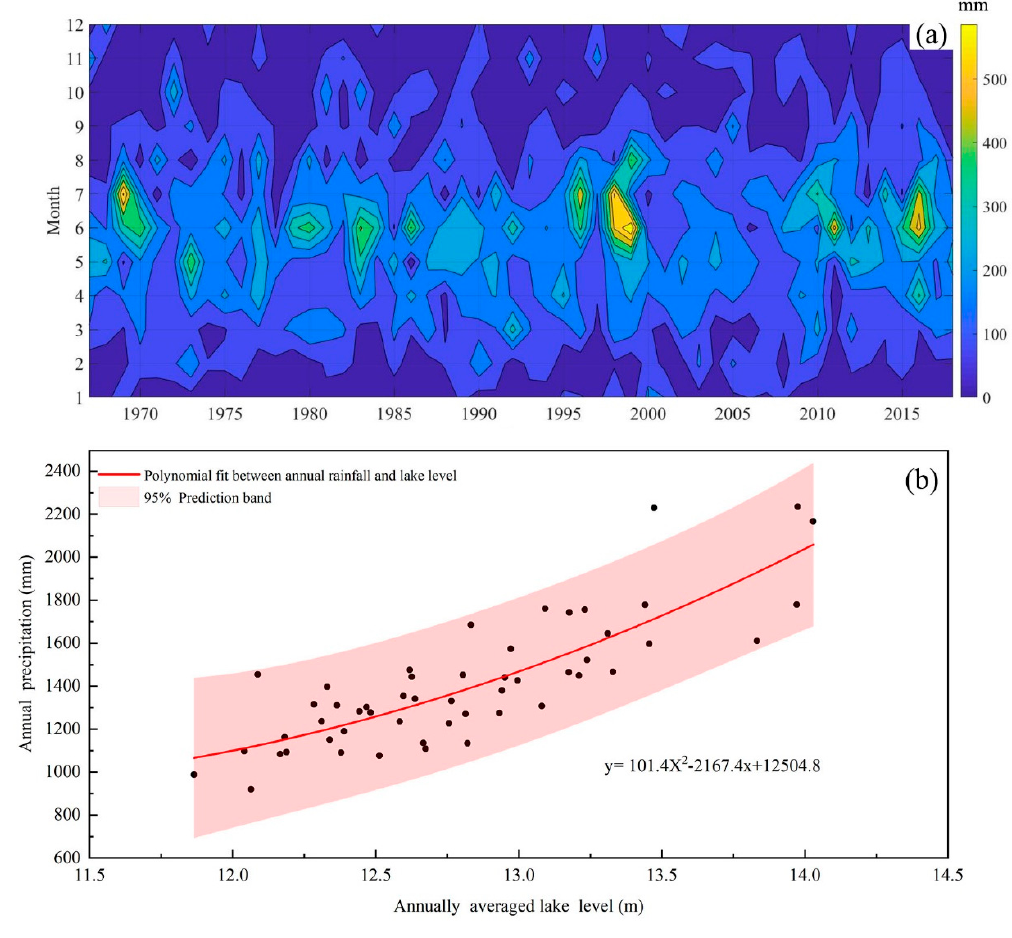
Figure 5. ( a ) Seasonal precipitation variation from 1967 to 2018 in Huayang Lakes Basin; and ( b ) Relationship between precipitation and water level of the Huayang Lakes.